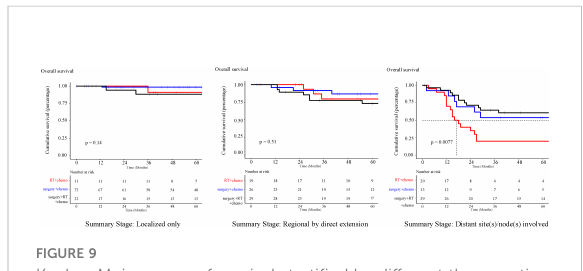
FIGURE 9 Kaplan-Meier curve of survival strati fi ed by different therapeutic